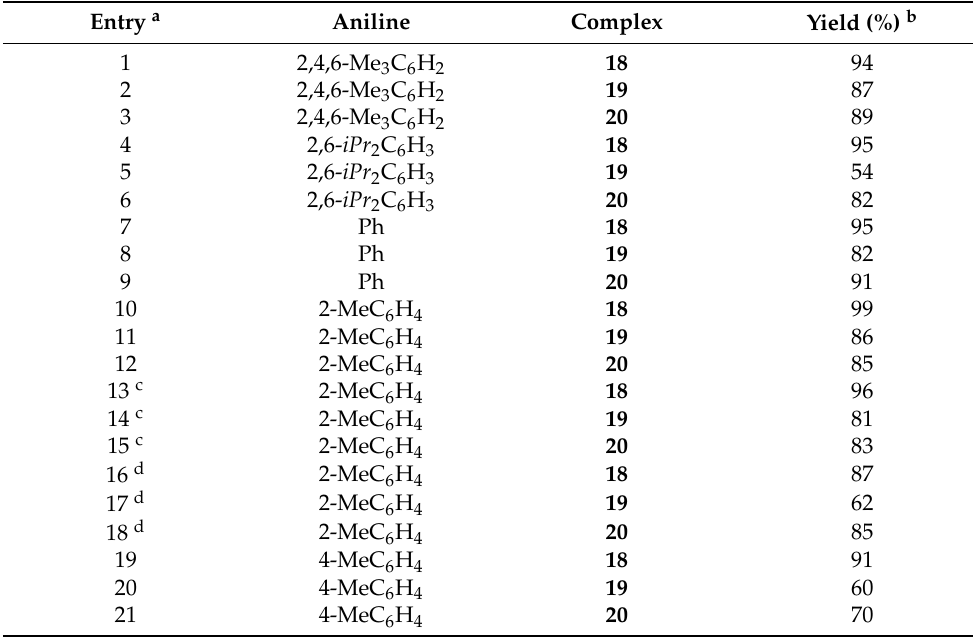
Table 4. Hydroamination of phenylacetylene with substituted